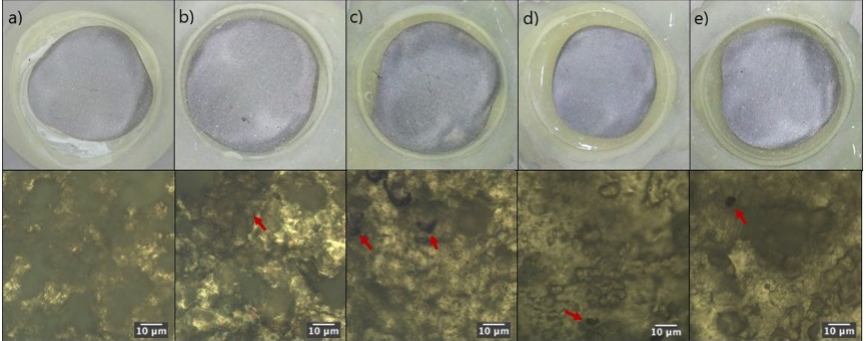
Figure 10. Picture of the exposed area on day 30 for sample ( a ) C1, ( b ) C2, ( c ) C3, ( d ) C4, ( e ) C5, and their respective optical micrograph (100×). The red arrow shows a possible pinhole corrosion area.